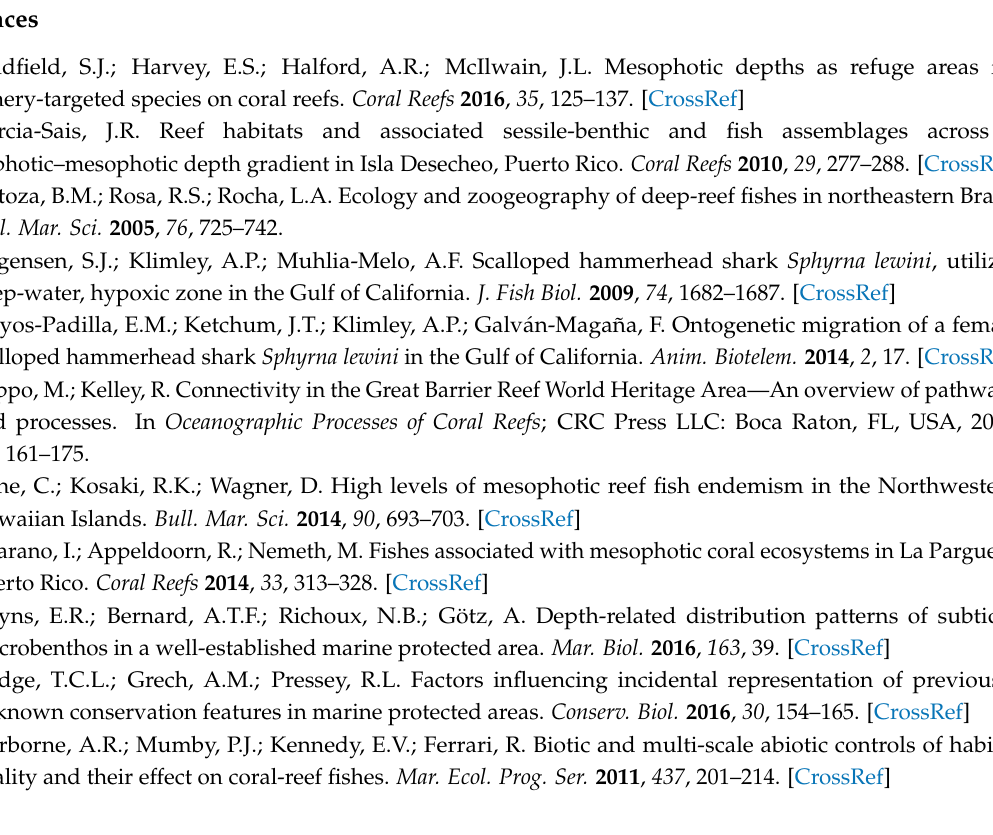
Figure S1: Examples of multibeam bathymetry, backscatter and derivatives for the Northern Submerged Shoals Figure S2: Epibenthic habitat measures by reef, Figure S3: Substratum habitat measures by reef, Figure S4: Non-metric multidimensional scaling showing fish community composition for Shallow sites (54–115 m), Figure S5: Non-metric multidimensional scaling showing fish community composition for Middle sites (128–160 m), Figure S6: Non-metric multidimensional scaling showing fish community composition for Deep sites (179–260 m); Table S1: Ecology of deep-reef fishes seen in deep Baited Remote Underwater Video Stations, Table S2: Habitat variables to understand variation in fish trophic